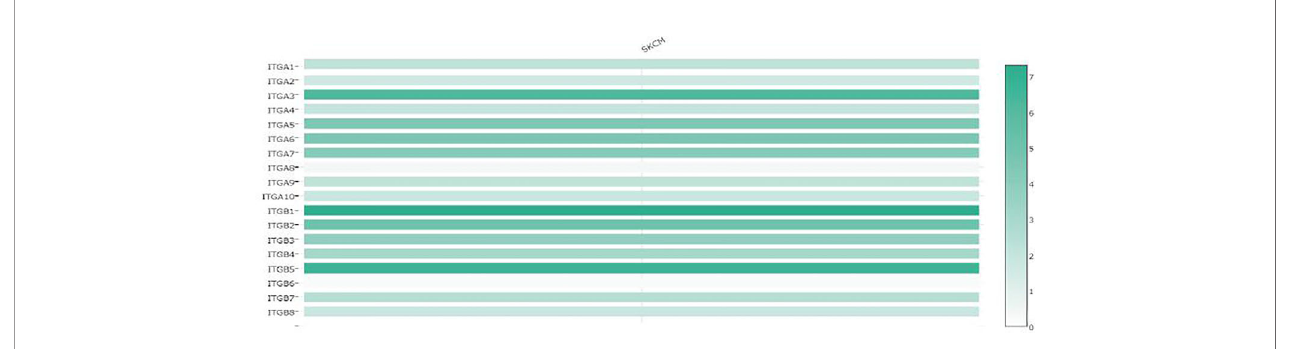
FIGURE 4 | The relative expression levels of integrin subunits